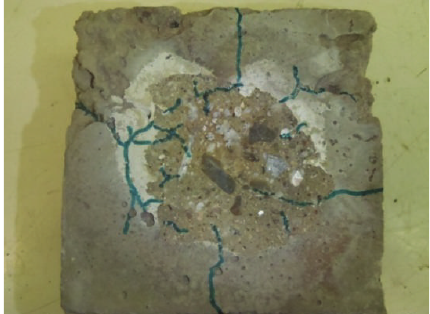
Figure 8: Detail of surface after heating with marked cracks, speci- men CEM I -